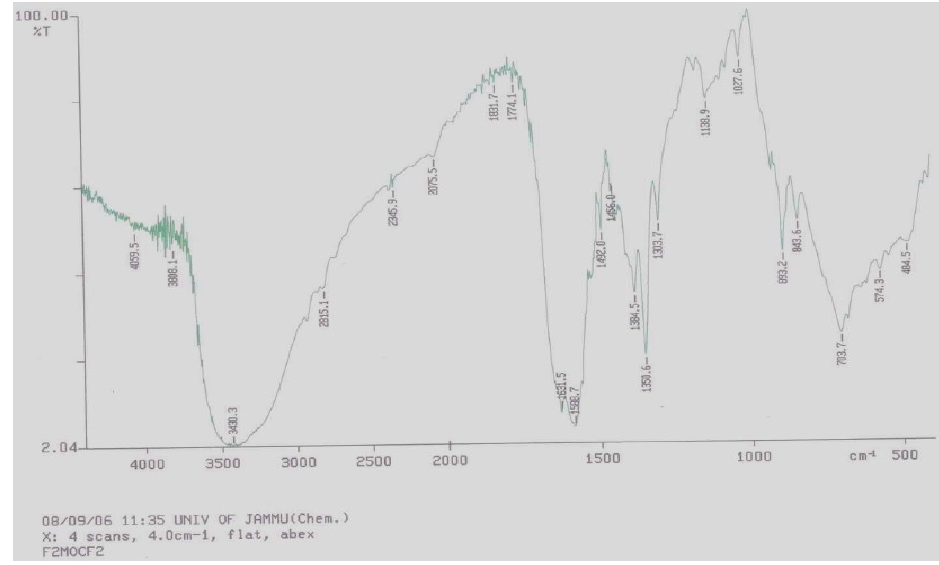
Figure 2. IR spectrum of [Mo(CO)